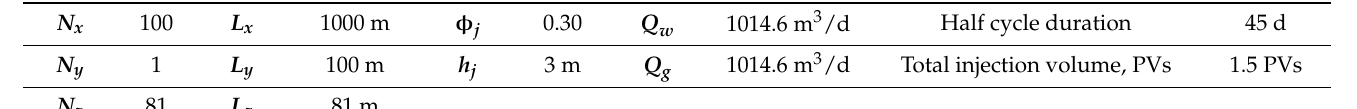
Table A1. Rock/grid properties and operational parameters. N denotes number of cells in each direction, L the respective lengths, Q the volumetric rate.